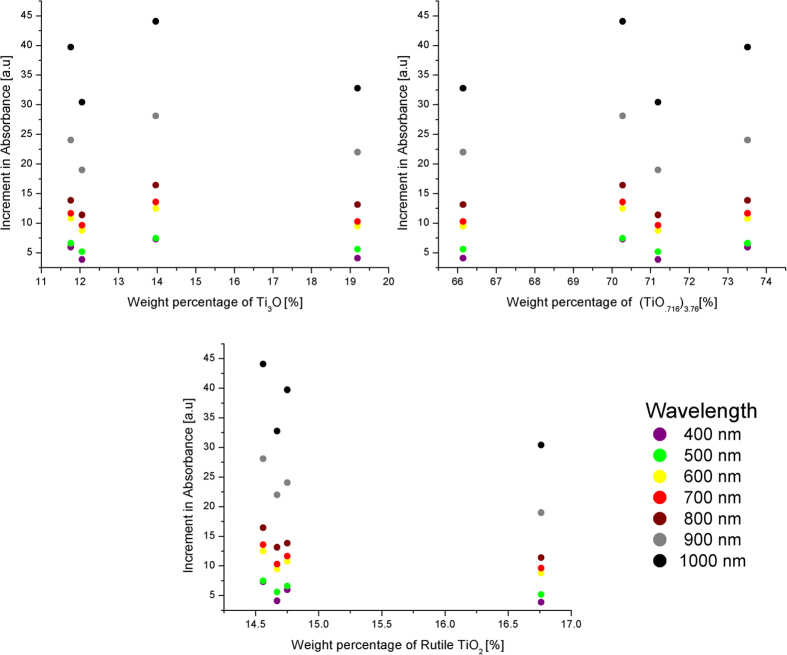
Increment in absorbance plotted against the weight percentage of the three oxides of titanium present in the multiphase laser transformed region: (a) Ti3O (b) (TiO.716)3.76 (c) TiO2.